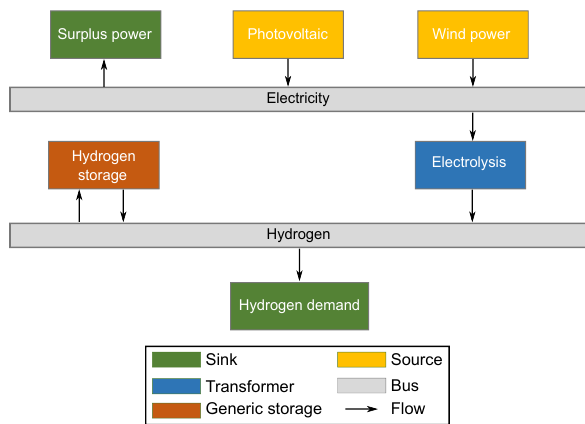
Figure 6. Block diagram of the OEMOF energy system.